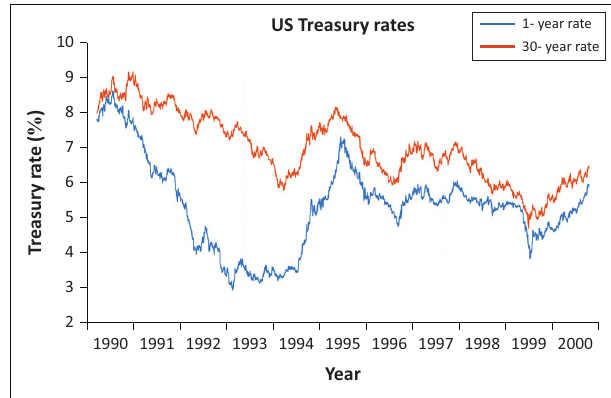
FIGURE 3: United Sates treasury